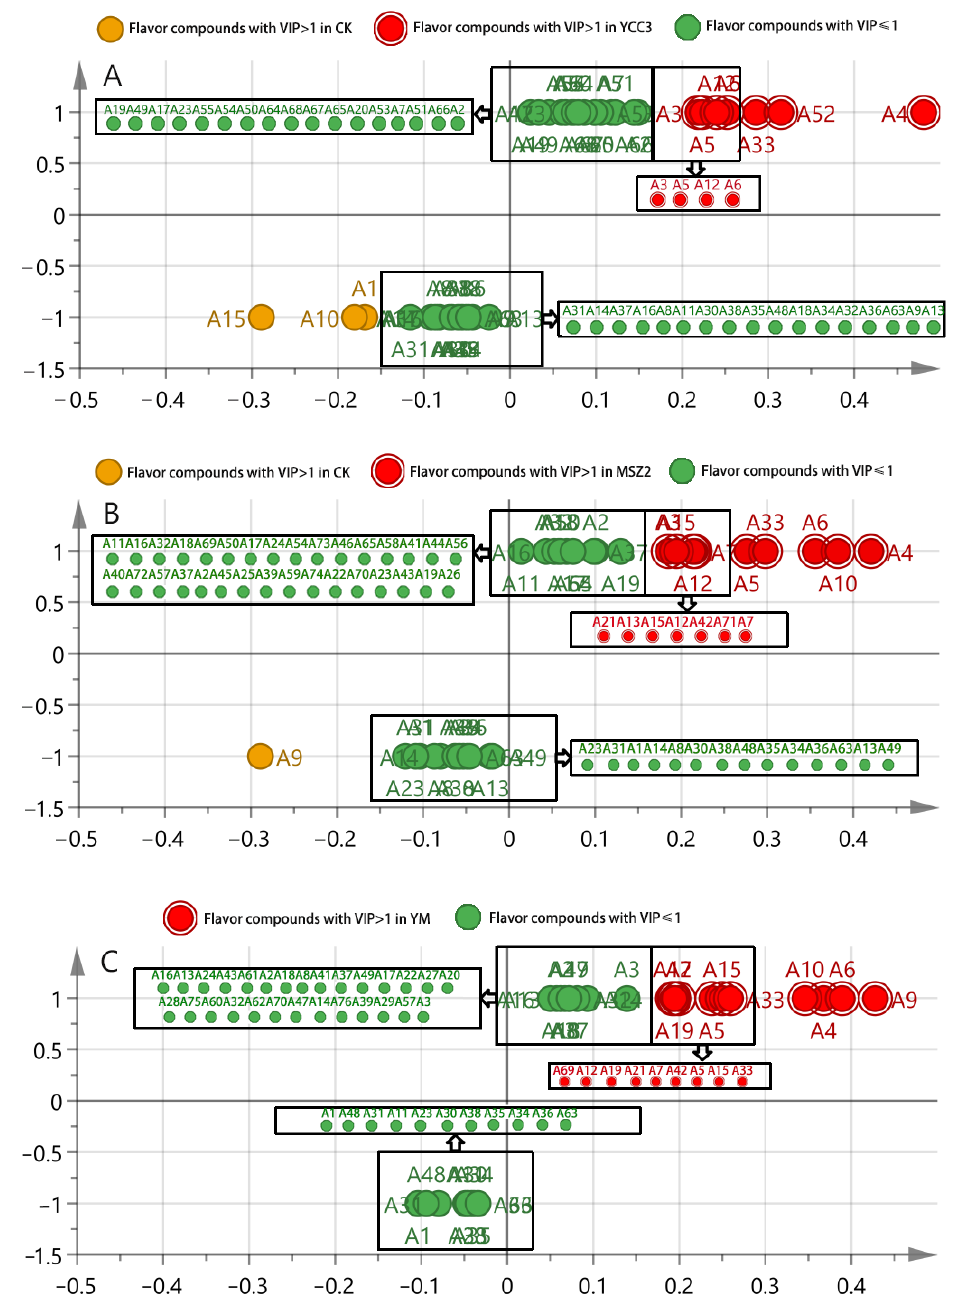
Figure 6. S-shaped loading plot obtained from OPLS-DA. ( A ) comparison between the CK and YCC3 groups; ( B ) comparison between the CK and MSZ2 groups; ( C ) comparison between the CK and YM groups.